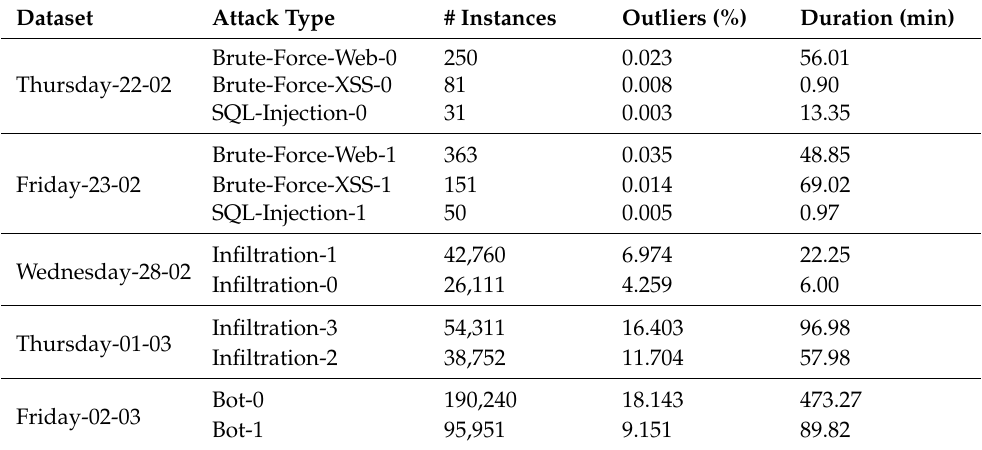
Table 6. A selection of attack scenarios with respective characteristics of the CSE-CIC-IDS2018